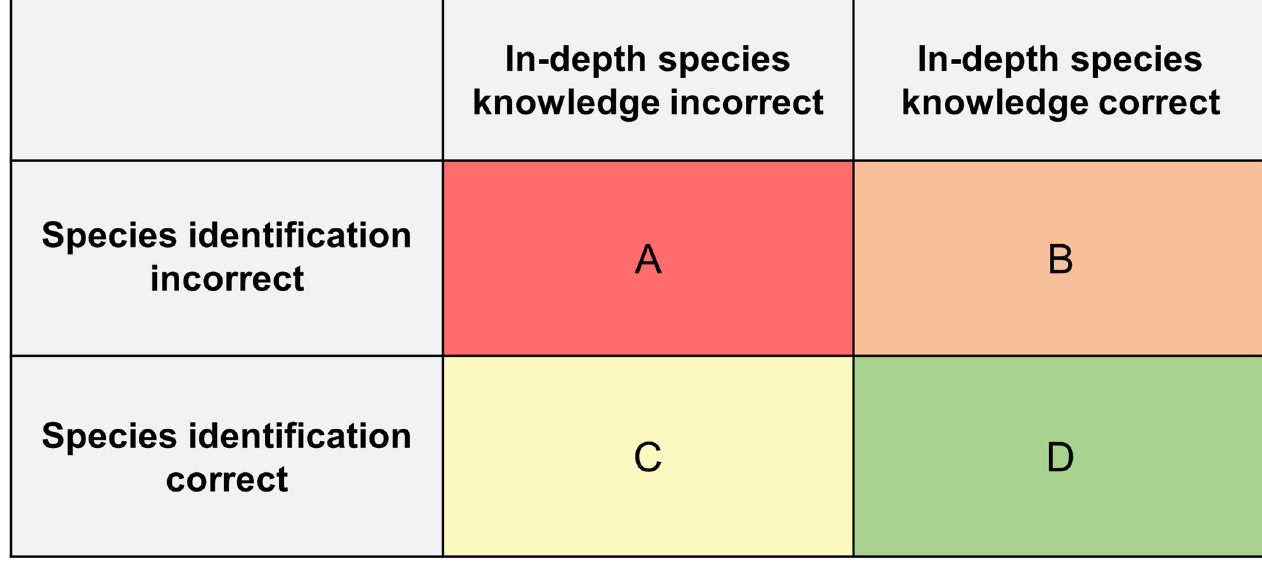
Fig 1. Odds ratios were calculated using the frequency counts in a 2 by 2 contingency table via the following formula: (A � D)/(B � C). Frequency counts of A, B, C, and D were determined per theme and in